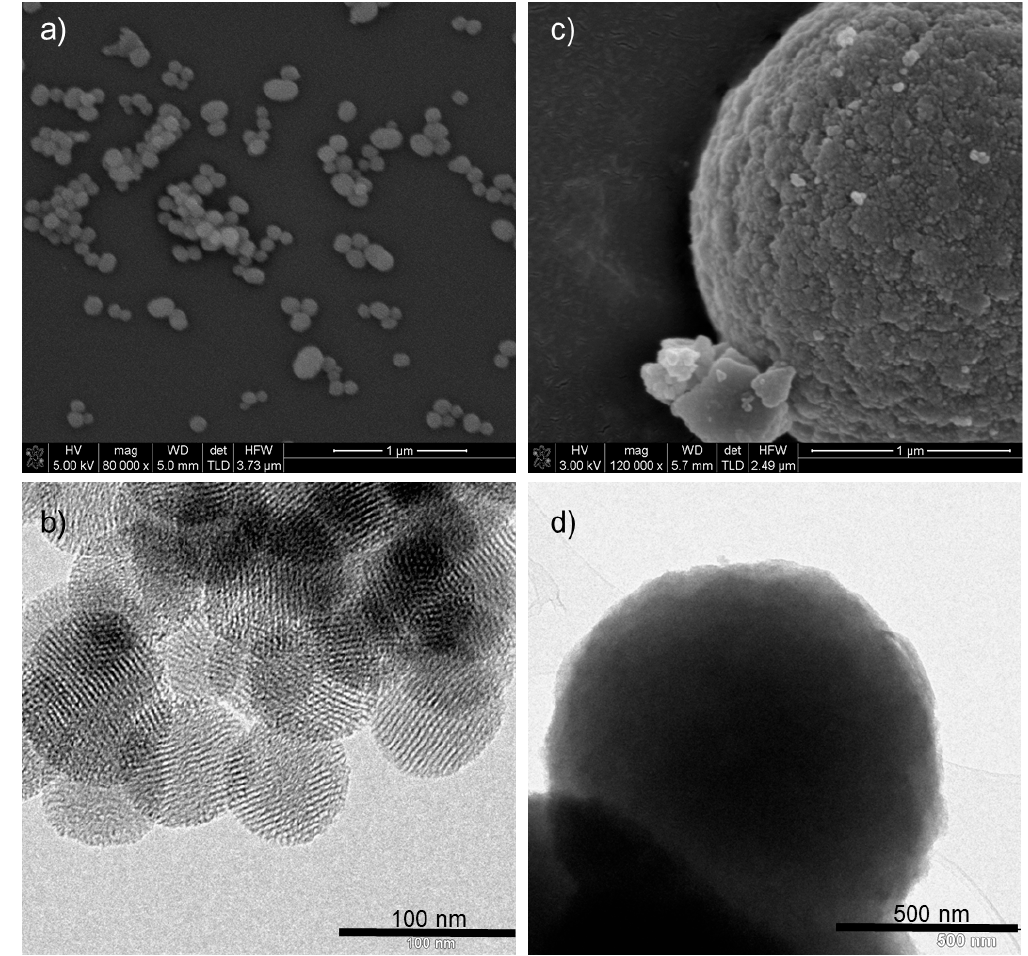
Figure 8. SEM and TEM images of some of the tin-functionalized materials: ( a ) SEM of MSN-AP-FA-Sn, ( b ) TEM of MSN-AP-FA-Sn, ( c ) SEM of MSU-2-AP-FA-Sn and TEM of ( d ) MSU-2-AP-FA-Sn.